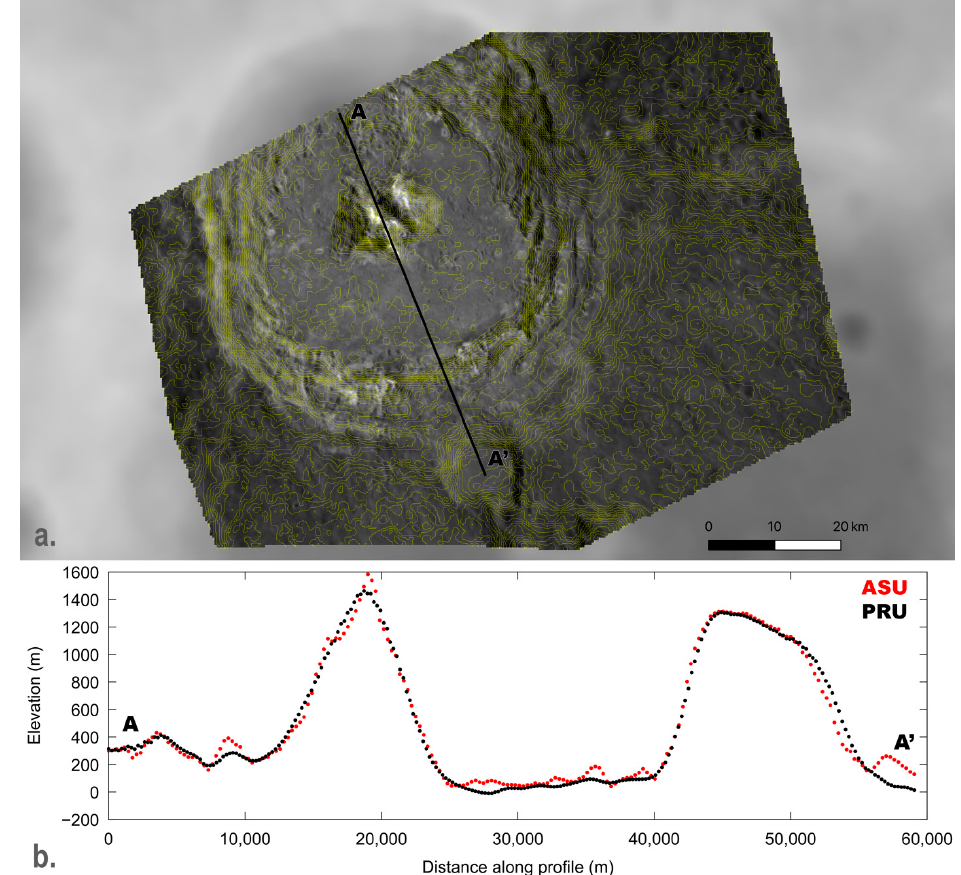
Figure 9. Kuiper crater profiles. Here, ASU DEM has been vertically translated by subtracting 934.4 m; no other alignment was performed. ( a ) ASU 90 m contour map overlaid on ASU orthophoto, shown over PRU DEM. ( b ) Elevations from ASU (270 m/px) and PRU (222 m/px) for profile A.